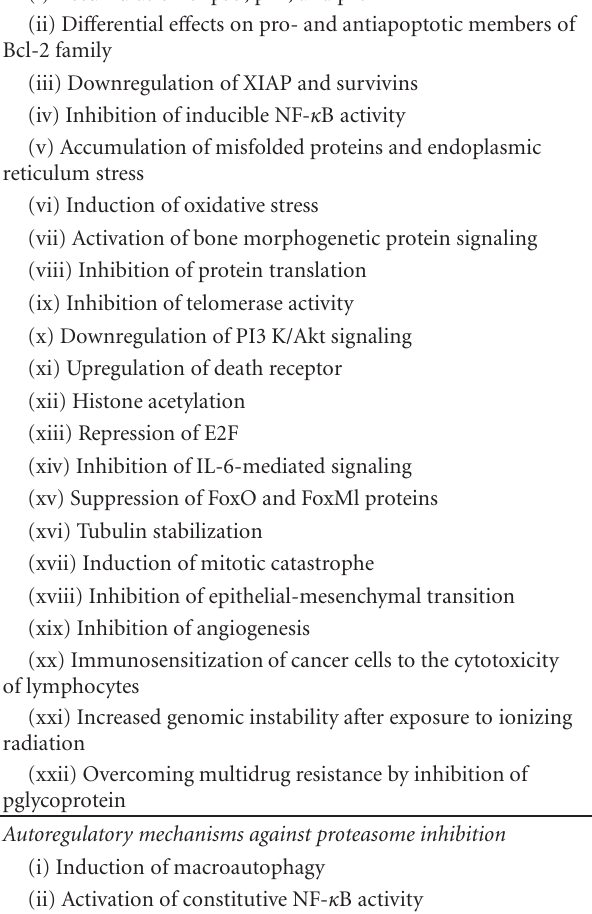
Table 1: Antitumor and autoprotective mechanisms triggered by proteasome inhibition. Possible antitumor mechanisms of protea- some